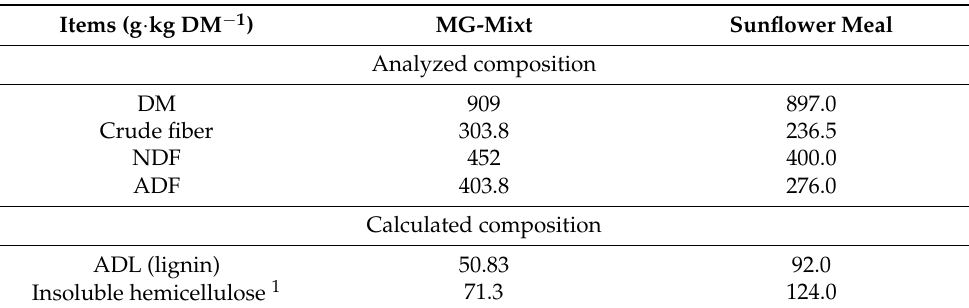
Table 2. Fiber composition of MG-mixt and sunflower